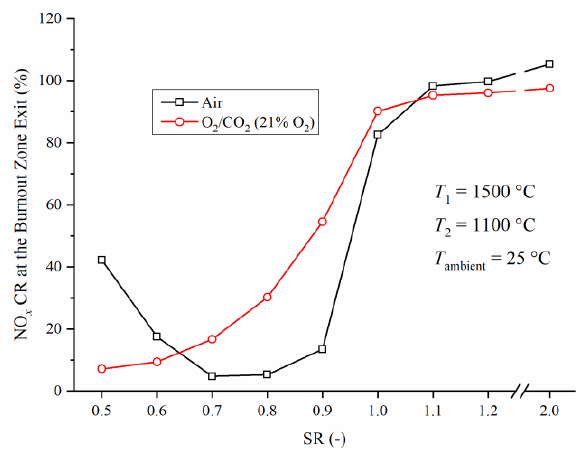
Figure 9. Comparison of NO x emissions between air combustion and O 2 /CO 2 combustion under different atmosphere